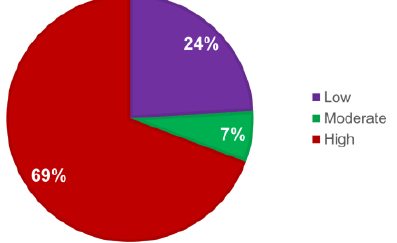
Figure 6. Percentage area coverage for the three degrees of susceptibility.